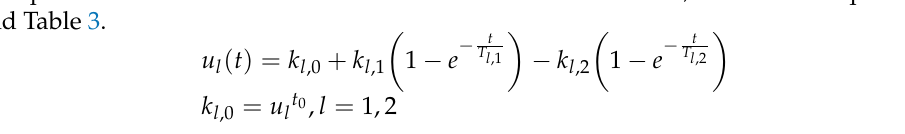
Table 3. Parameters of continuous transition function for manipulated